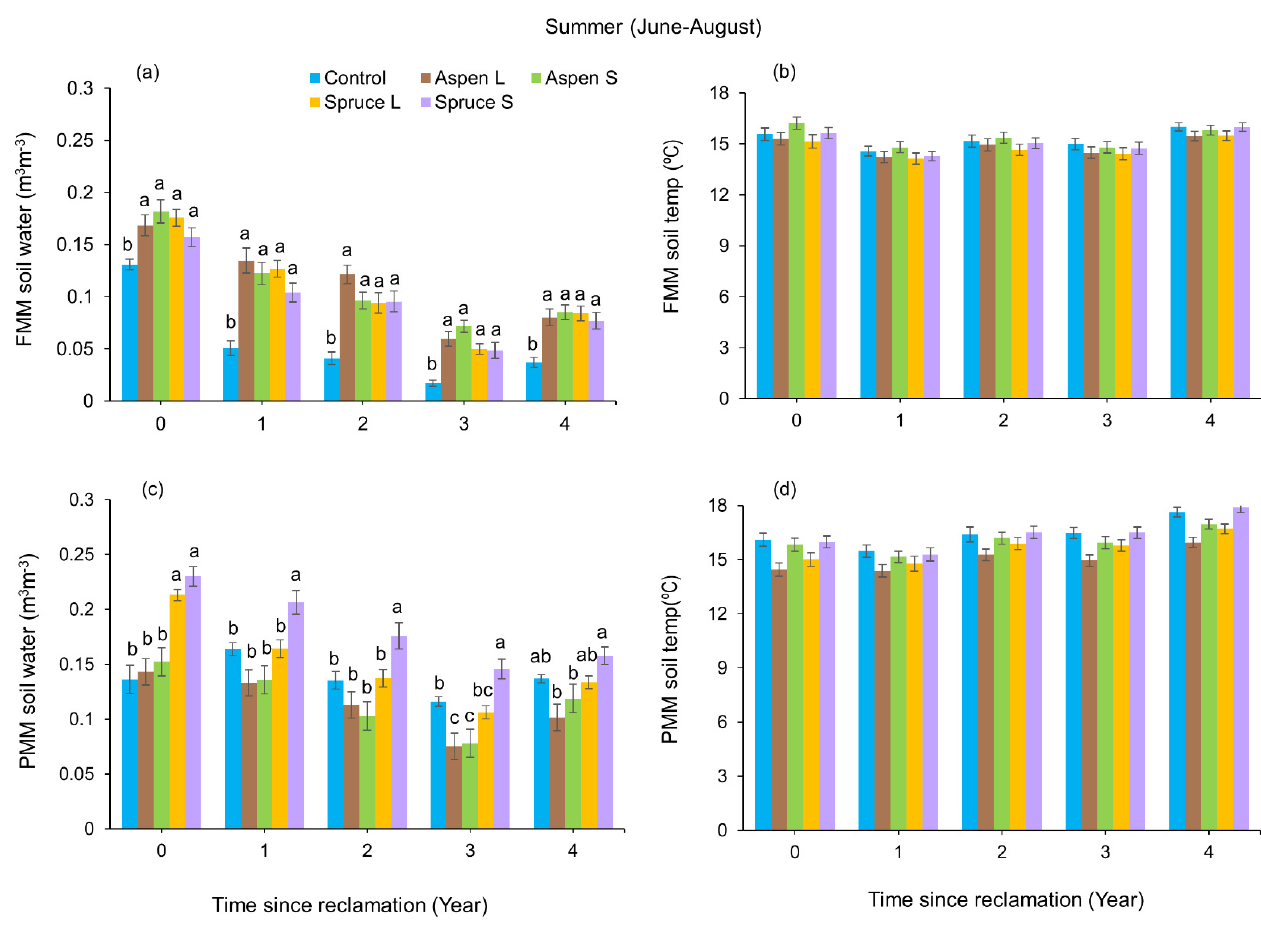
Figure 5. ( a – d ) Mean summer soil water content and temperature by cover soil type at the research sites. Different letters indicate significant differences at p = 0.05 in Tukey HSD post hoc comparisons. FFM = forest floor mineral soil mix; PMM = peat minerals soil mix; L = large diameter (>15 cm); S = small diameter (2–4.9 cm).